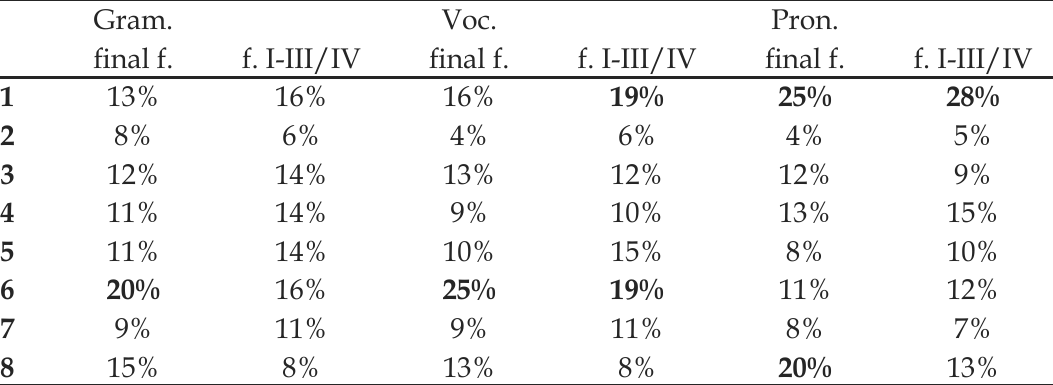
Table 4. Frequency of formative assessment provision in the case of FL subskills Gram. Voc. Pron. (cid:192) nal